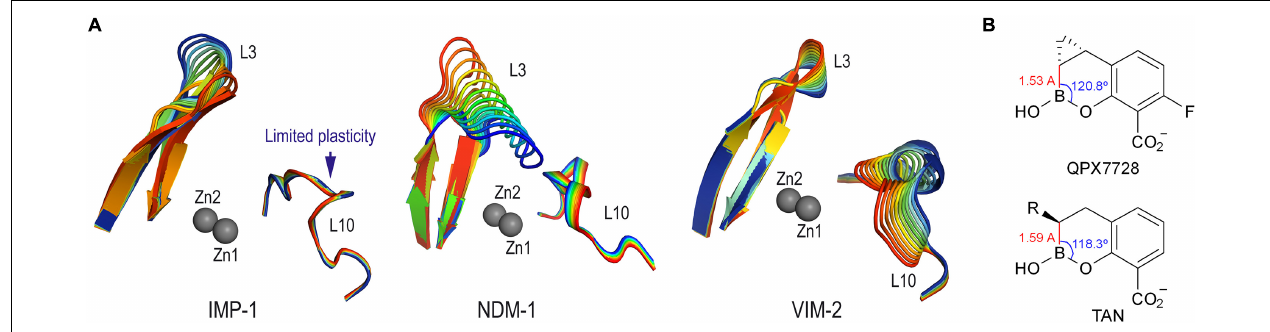
FIGURE 7 | (A) Detailed view of the intrinsic induced-fit motion of the L3 and L10 loops of IMP-1, NDM-1 and VIM-2 enzymes obtained by examination of the vibrational modes. The main vibrational modes are shown. Zn(II) ions are shown as spheres. Note how IMP-1 is the enzyme in which the loop that surrounds the two metal centers (L10) has the least plasticity. (B) Relevant carbon-boron distances and carbon-boron-oxygen dihedral angles in QPX7728 and